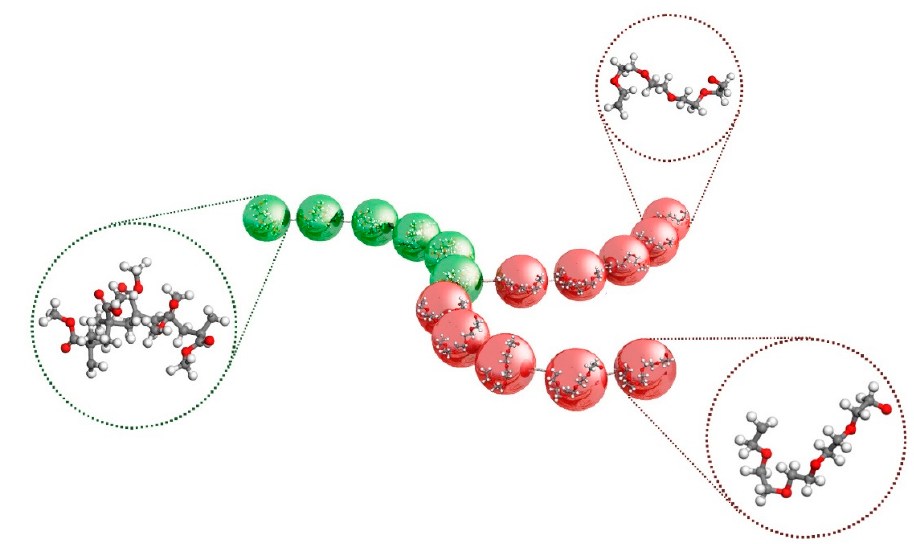
Scheme 1. Schematic representation of the Y-shaped copolymer. The red particles representing the coarse-grained EO blocks are denoted A, and the green particles representing the coarse-grained MMA blocks are denoted B. Three molecular structures in three individual beads are amplified in dotted circles; herein, red, grey and white balls denote oxygen, carbon and hydrogen atoms, respectively.